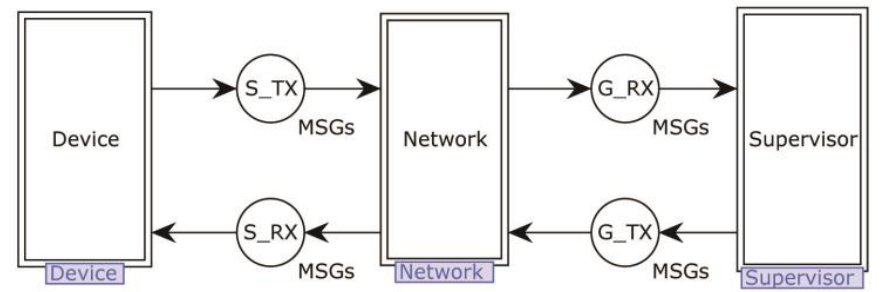
Figure 5. Top-level model of PEASE protocol. The top-level model consists of three alternative transitions; according to the protocol rules, the Device sends requests, and the Supervisor processes and responds; the whole process consists of one